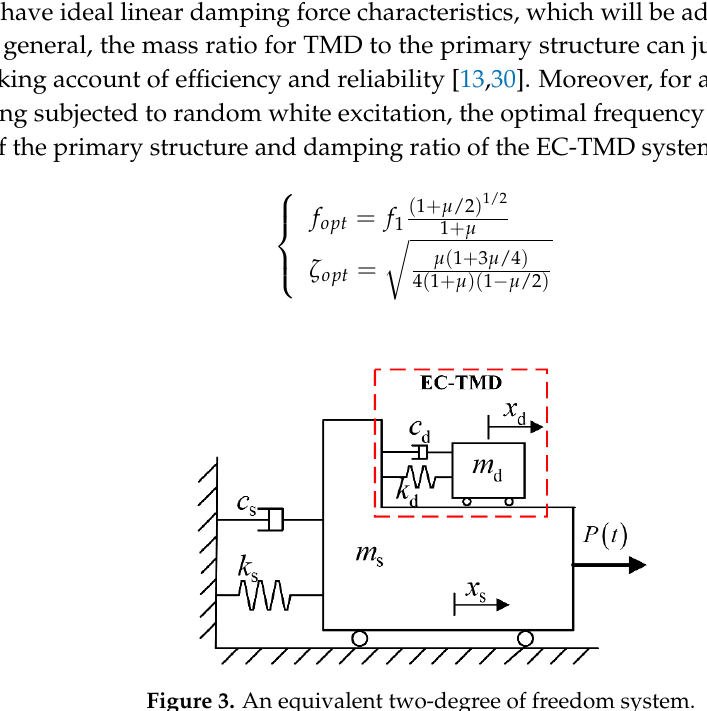
Figure 3. An equivalent two-degree of freedom system.